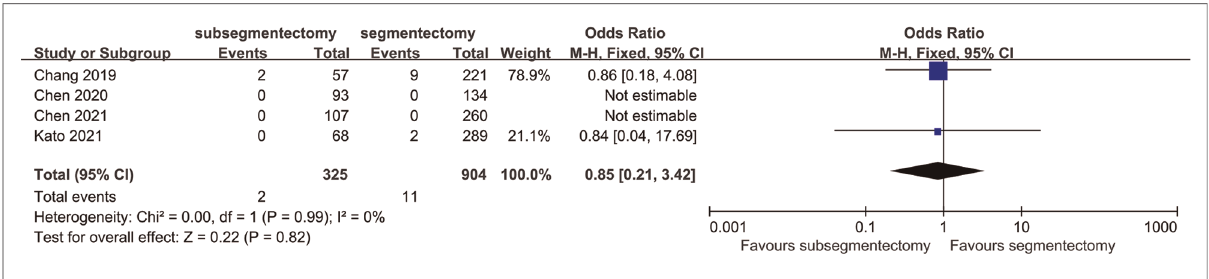
FIGURE 2 Forest plot: the recurrence rate of subsegmentectomy vs. segmentectomy.